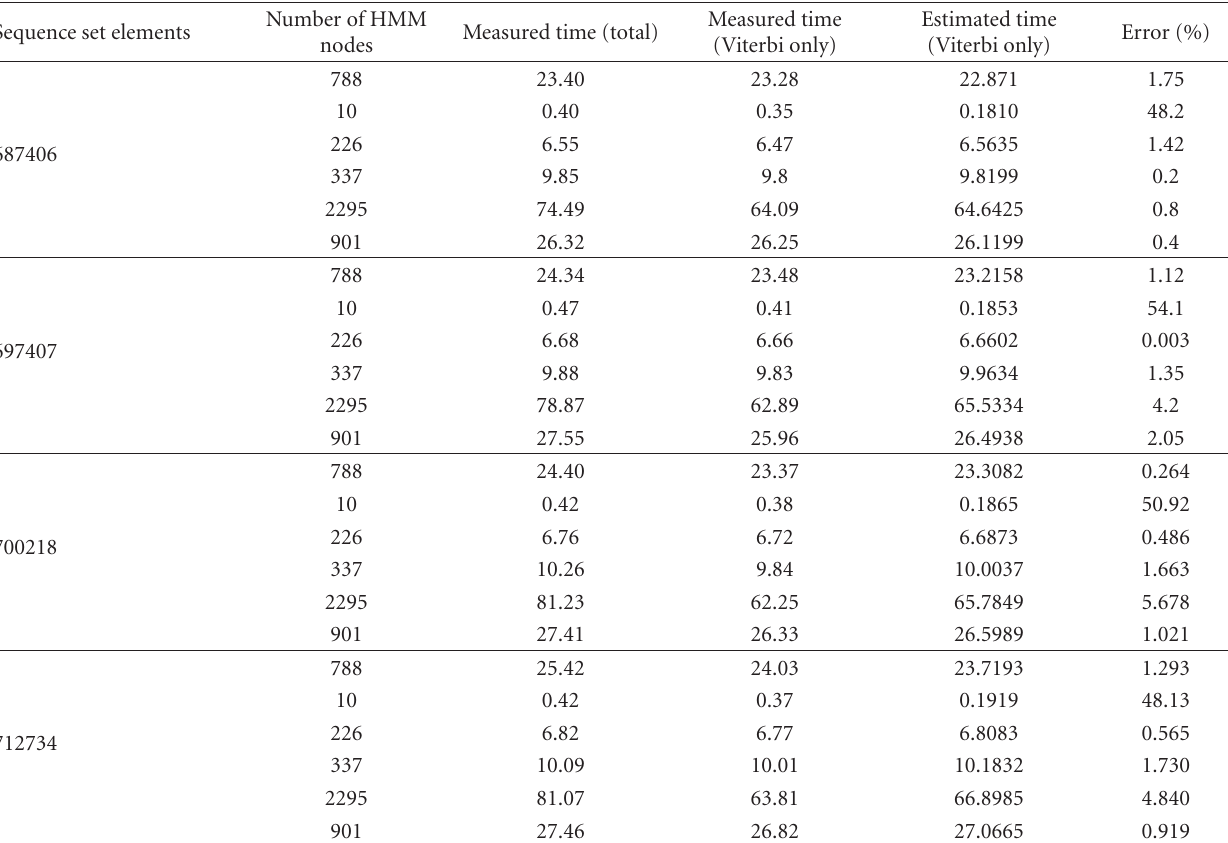
Table 4: Modified hmmsearch performance